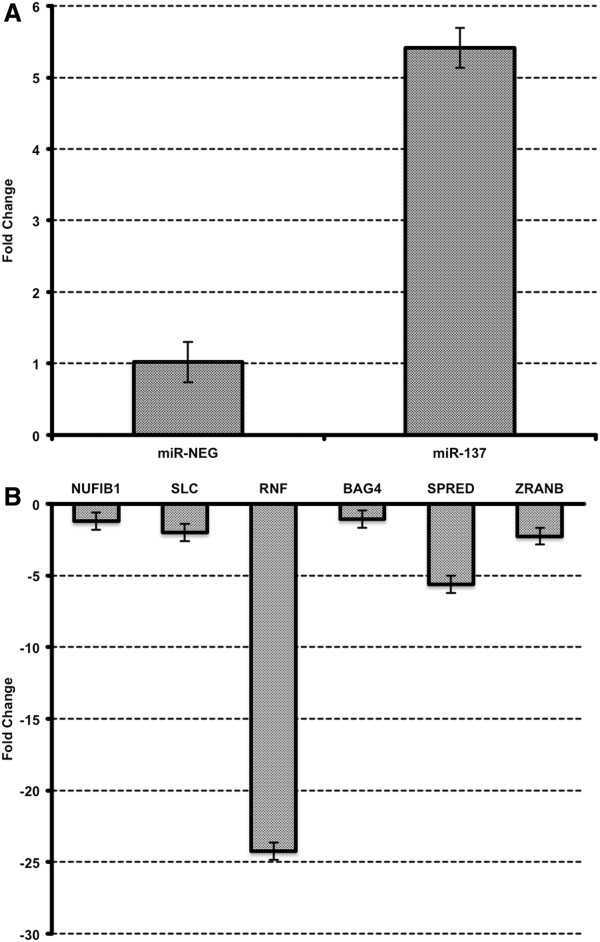
Effect of the transfection of microRNA mimic of miR-137. A. Transfection of neuroblasts showing basal expression of miR-137, based on which our experiments on miR-137 target genes were carried out. B. Column chart of fold changes of expression values (qRT-PCR) between SH-SY5Y transfected with miR-137 mimic or miRNA mimic negative control. Values are based on fold change calculated from 2-ΔΔCt method. All the columns have significant P value of <0.05 as calculated by Student's t-test.